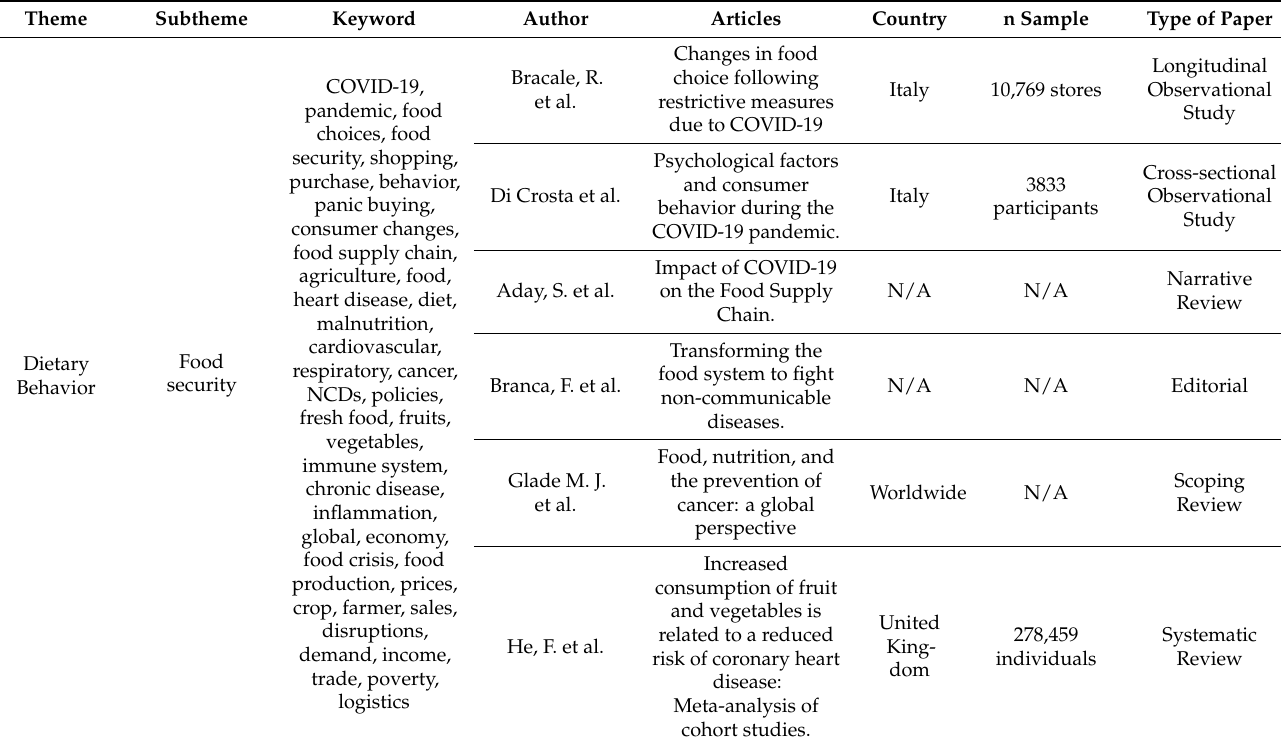
Table 1. Search Strategy, Study Selection on the Effects of the COVID-19 Pandemic and Restric- tion